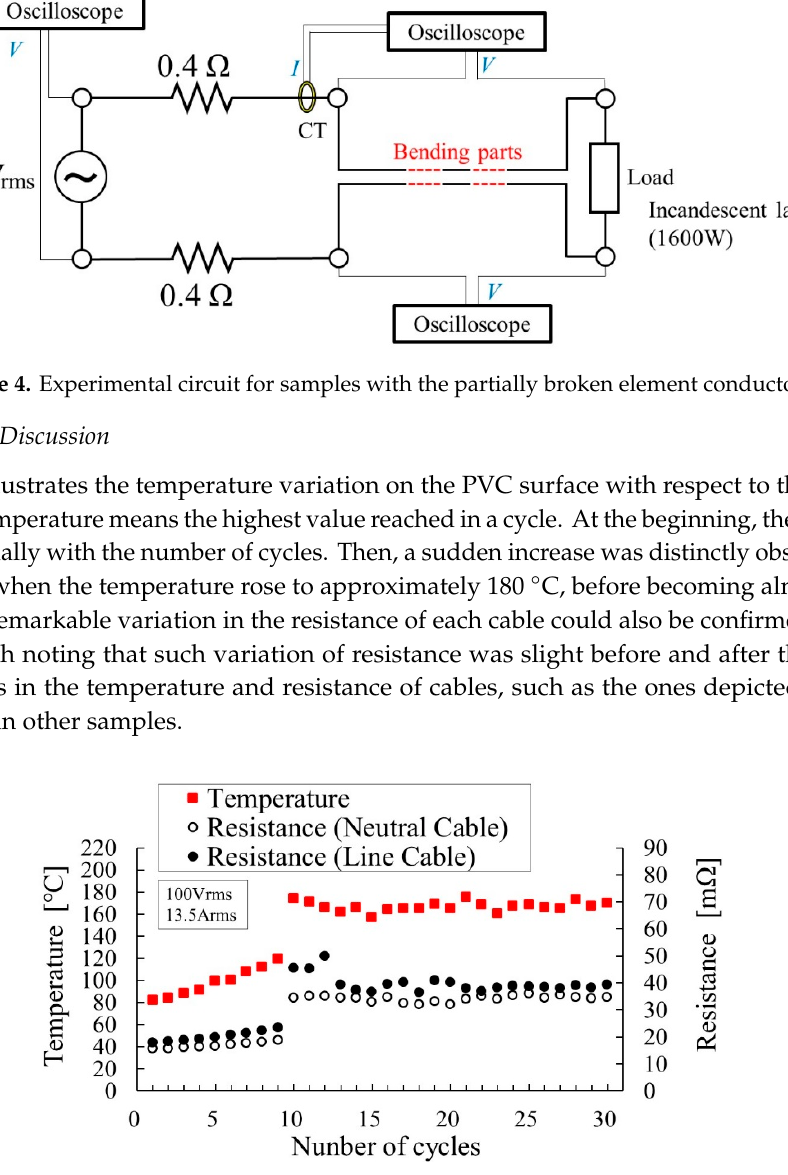
( b ) Figure 3. Example of X-ray computed tomography image. ( a ) overall image ( b ) magnified image of circled part in ( a ). The present sample is similar to a sample described in UL1699 standard [5], which is used for a parallel arc experiment. The latter is prepared by slicing PVC across the wire to reveal the conductor and then the wire is wrapped with two layers of electrical tape and two layers of fiberglass cloth tape. Conducting path across the insulation at the slit is created using a high voltage power source [7]. Conversely, PVC is not sliced in the present sample, which is probably close to a practical situation. 2.2. Experimental Procedures The experimental circuit is shown in Figure 4. Here, an AC voltage of 100 Vrms and 60 Hz was supplied to the sample from a distribution board in the laboratory. The resistance of the internal wirings was simulated with two 0.4 Ω resistors. A 45 cm long sample cord was laid straight and flat, with the load being eight incandescent lamps (1600 W in total). Combustibles cut from a cushion were placed on the sample to cover the two partially broken parts. The principal component of the combustibles was dry cotton. The voltage and current waveforms were recorded simultaneously using a digital oscilloscope (Tektronix TDS3034B). Subsequently, these voltage and current data were applied for calculating the resistances of the cables. An infrared thermometer (Keysight U5855A) and a video camera were also used. Based on the preliminary experiments, the temperature on the PVC surface increased just